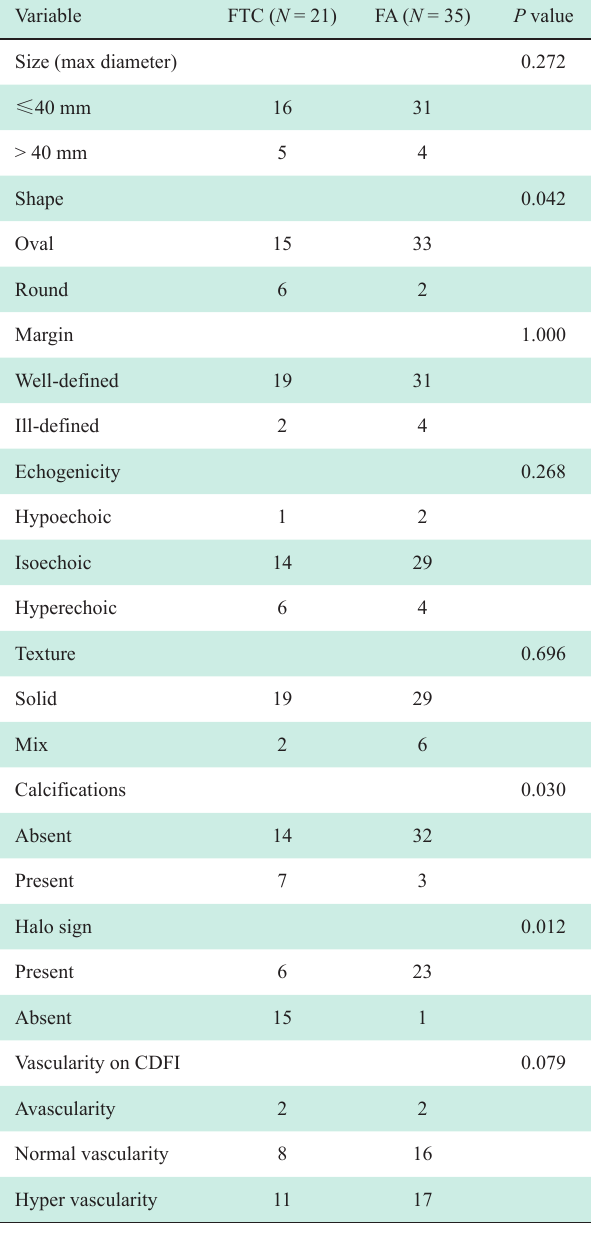
Table 3 Comparison of contrast enhancement patterns between Follicular Thyroid Carcinoma (FTC) and Follicular Adenoma (FA)